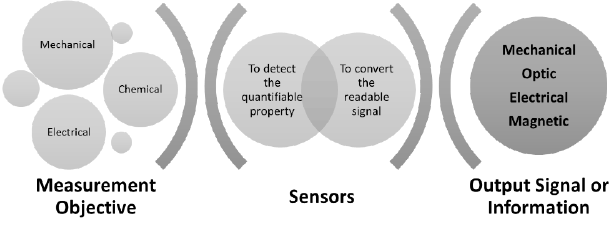
Figure 1. Sensor’s